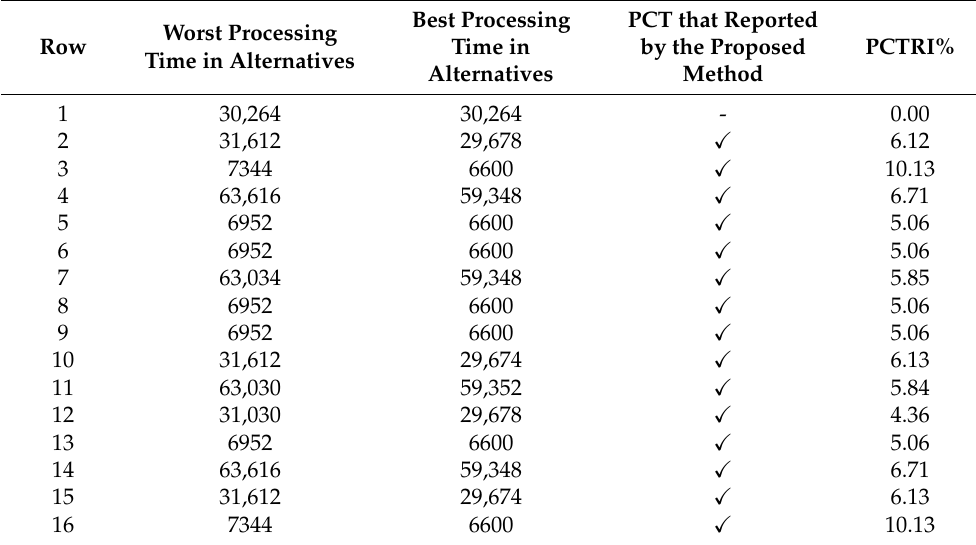
Table 11. The results of PCTRI% for studies solved by the proposed